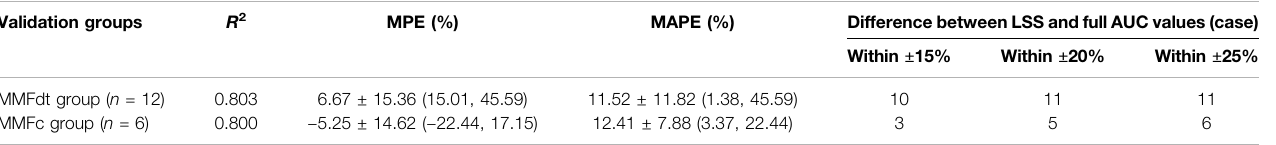
TABLE 5 | External validation of model 4 using model validation group and MMFc group.